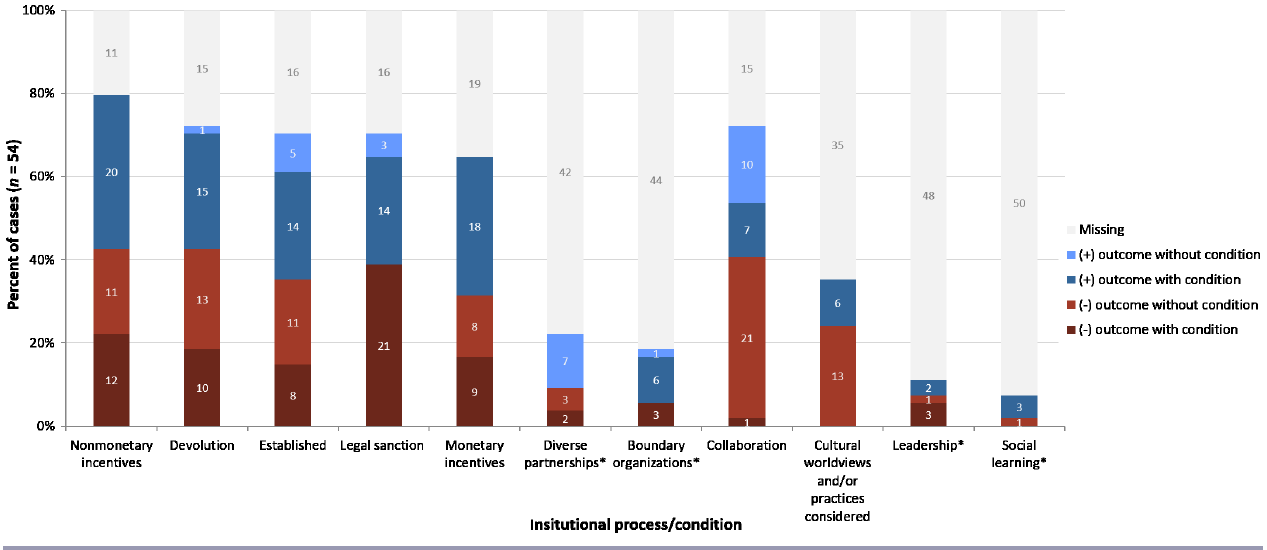
Fig. 8 . Association between the institutional processes, or conditions, and outcomes. Social and ecological outcomes were pooled (no case reported positive social and negative ecological outcomes, or vice versa). The total number of cases included in this analysis was 54 (65 total cases minus 11 cases with mixed outcomes). The Fisher exact test was used to test the null hypothesis that there was no association between each condition and outcome. Asterisks denote conditions with low sample size that precluded test of association. Five conditions were significantly associated with reported outcomes: (1) nonmonetary incentives ( p = 0), (2) monetary incentives ( p = 0.001), (3) devolution of rights ( p < 0.01), (4) collaboration ( p < 0.001), and (5) cultural worldviews considered in the model ( p = 0). Counts in the bar graph represent the number of